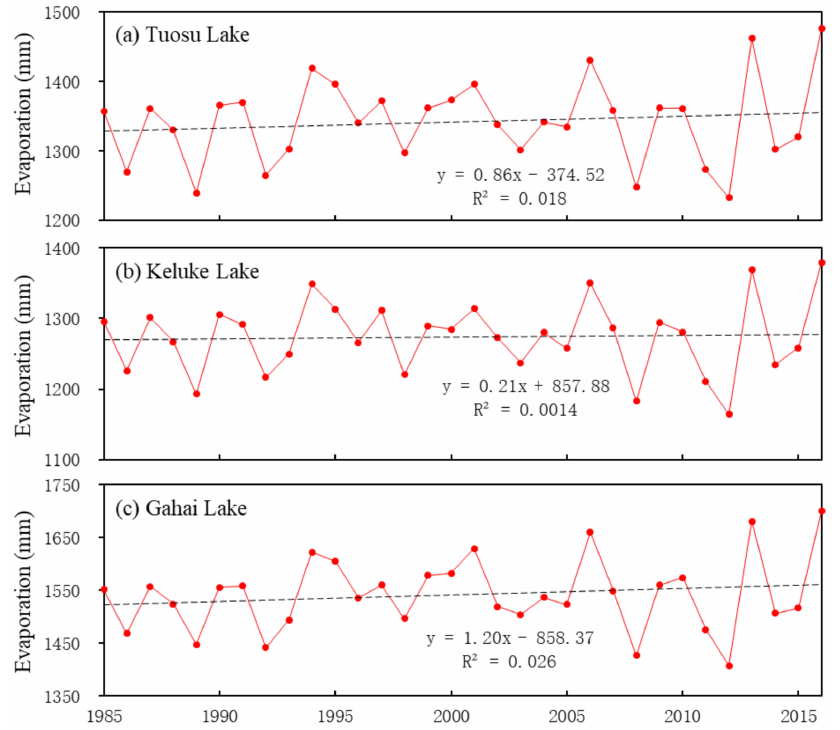
Figure 4. Plots exhibiting the evaporation of Tuosu ( a ), Keluke ( b ), and Gahai Lakes ( c ) calculated by the improved Penman–Monteith